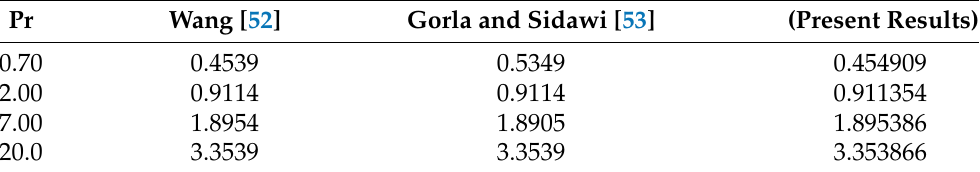
Table 2. A comparison of − θ (cid:48) ( 0 ) for various values of Pr when M = λ = N r = E I = S B = σ t